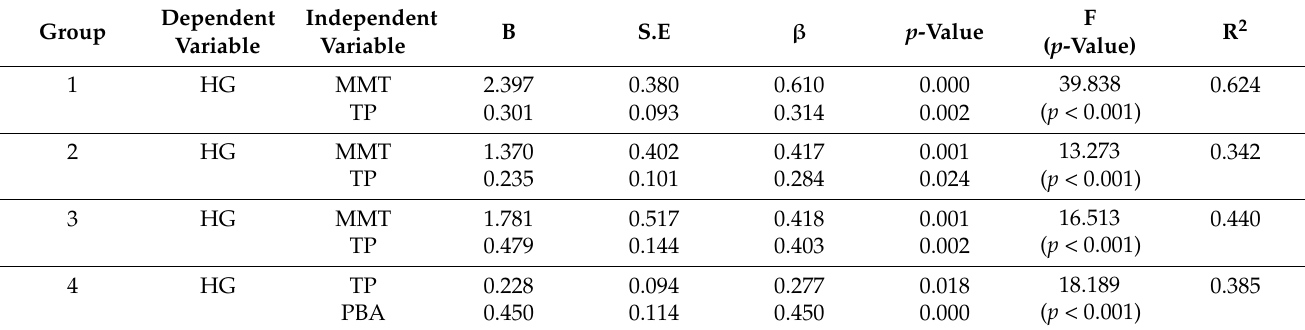
Table 6. Stepwise multiple linear regression analysis of handgrip strength in each